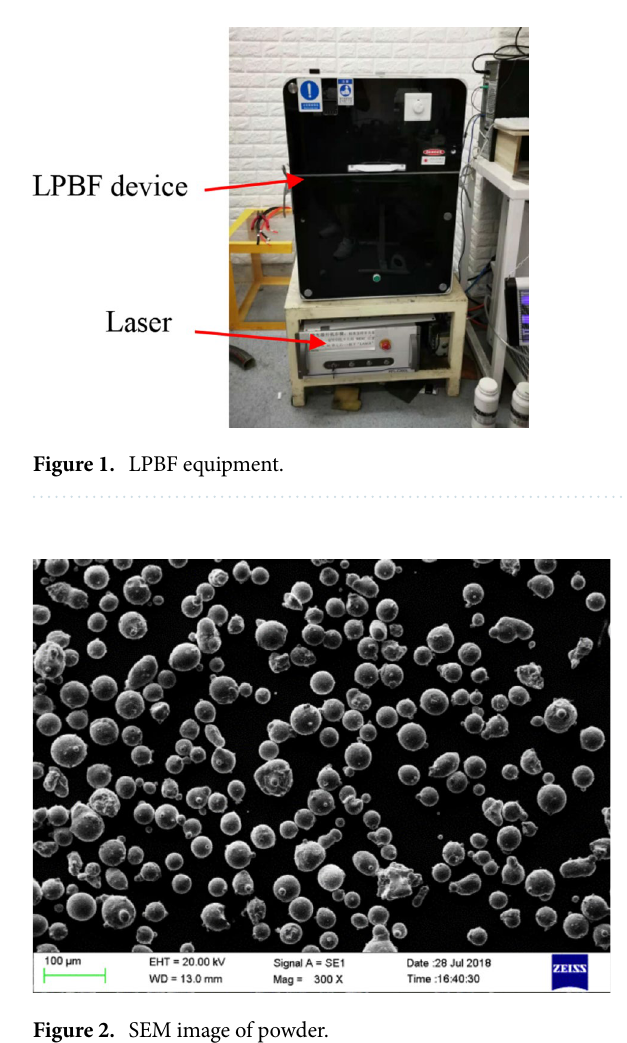
Figure 2. SEM image of